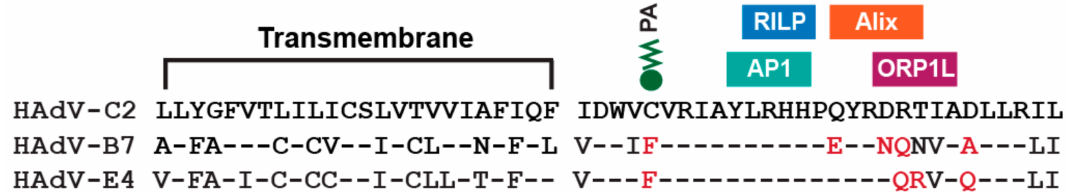
Figure 3. Sequence alignment of published RID- α transmembrane and cytosolic tail sequences from adenovirus serotypes HAdV-C2, HAdV-B7, and HAdV-D4. HAdV-C2 RID α is known to interact with multiple cellular proteins described in the text, and is also reversibly modified with palmitic acid (PA) at Cys67. Divergent amino acids a ff ecting the Cys67 palmitoylation site, or introducing negative / positive to uncharged amino acid substitutions, are highlighted in